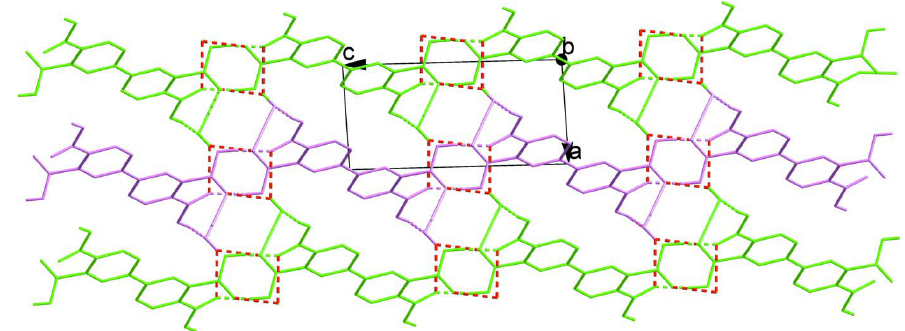
Figure 3 The two dimensional hydrogen-bonding layered structure along [011] direction.